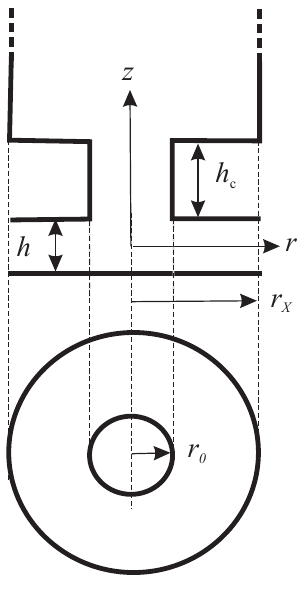
Figure 8 . Topology and dimensions of the axisymmetric perforation